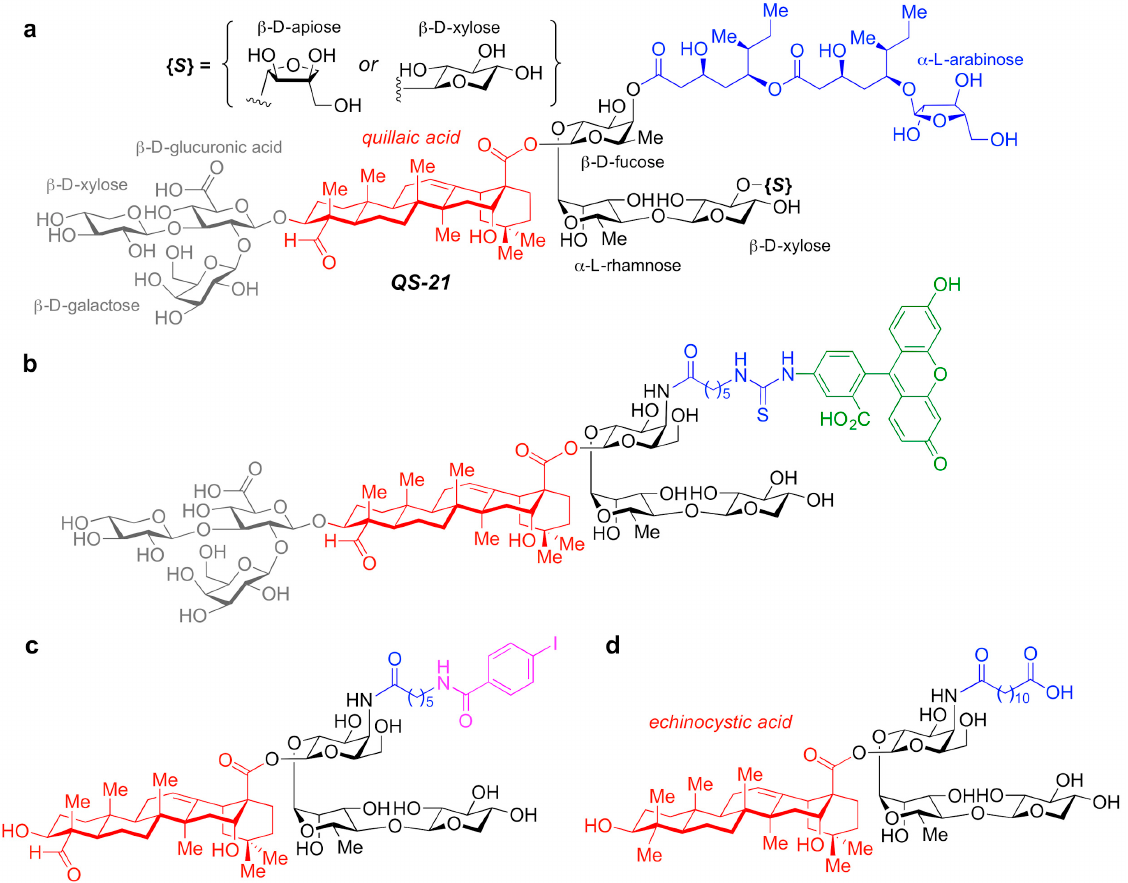
Figure 5. ( a ) Chemical structure of QS-21 saponin natural product adjuvant. ( b – d ) Synthetic saponin variants based on QS-21.